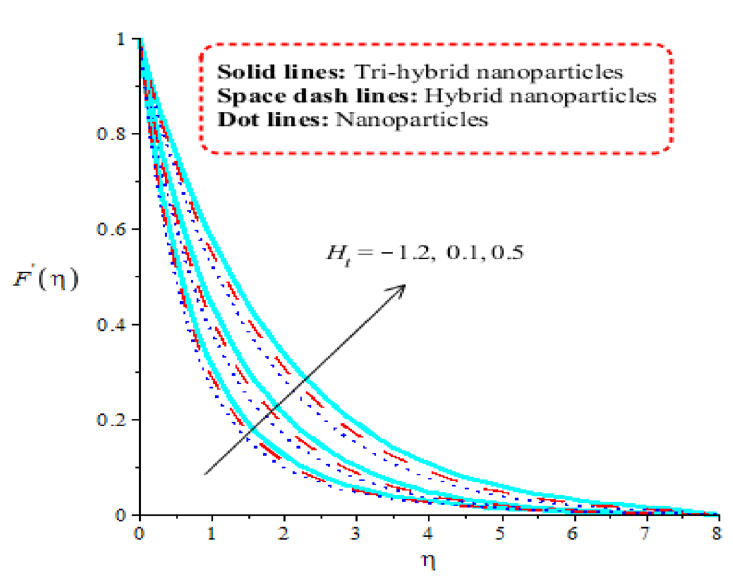
Figure 4. Distribution in F ′ (η) against H t